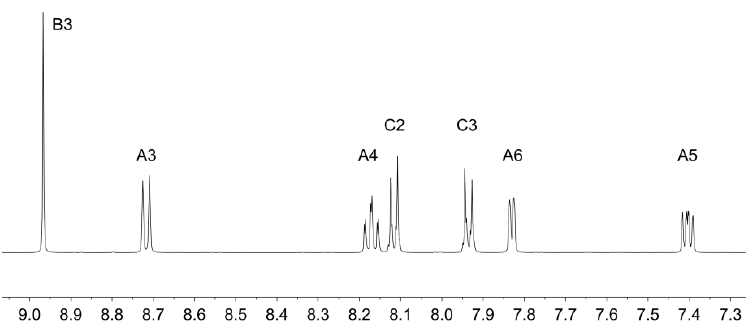
Figure 1. The 1 H NMR spectrum (500 MHz, CD 3 CN) of [Zn( 1 ) 2 ][CF 3 SO 3 ] 2 (see also Figure S5). See Scheme 2 for atom labels.